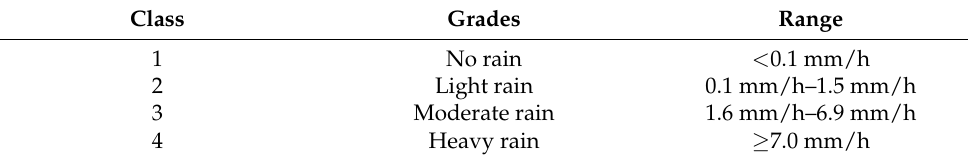
Table 2. Classification of precipitation grades based on meteorological